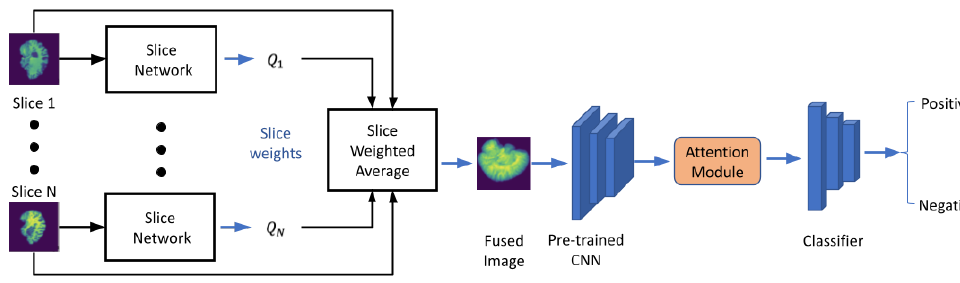
Figure 1. The workflow of our proposed CNN